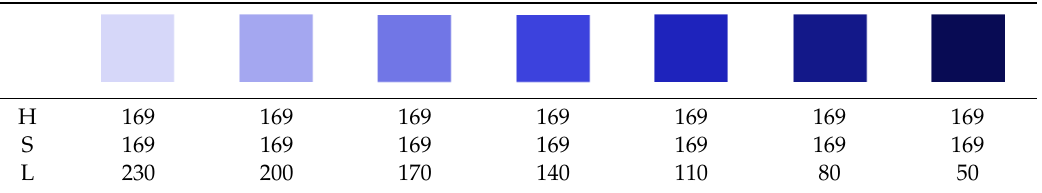
Figure 14. Experimental setup for selecting color values. In the experiment, we used the hue, saturation, lightness (HSL) color model, which includes color and lightness. Table 2. Candidates for color perception. Participants were asked to select a color for the virtual cube that appeared to be the most similar color to the actual cube among color candidates (e.g., a blue color in six areas).